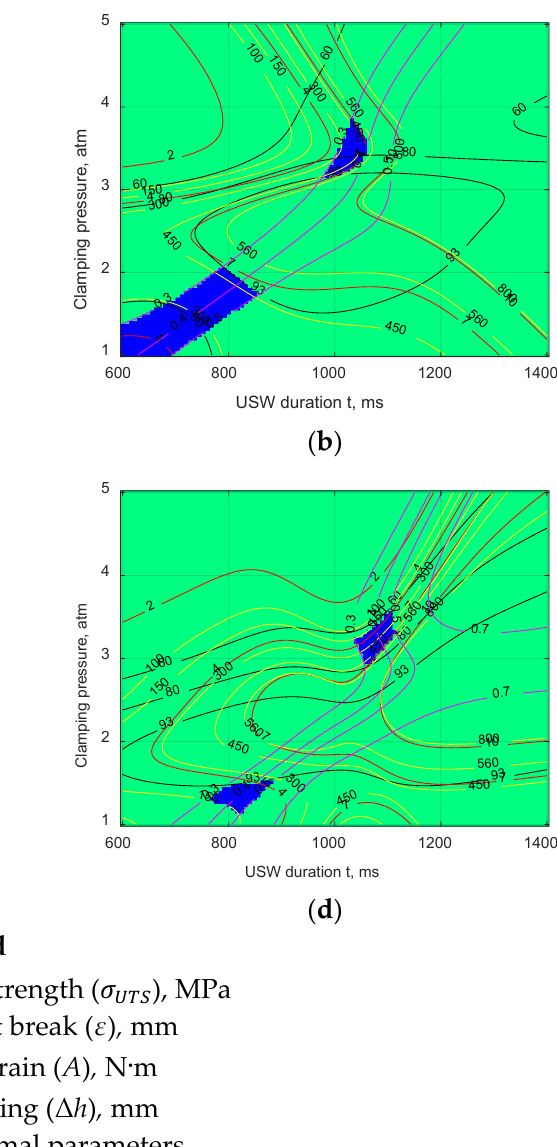
Legend ultimate tensile strength ( ), MPa elongation at break ( ε ) , mm 𝜎𝜎 𝑈𝑈𝑈𝑈𝑈𝑈 work of strain ( A ) , N·m joint thinning ( Δ h ) , mm areas of the optimal parameters Figure 7. The graphs in the isolines for the sections of the space of ANN parameters; the clamping Figure 7. The graphs in the isolines for the sections of the space of ANN parameters; the clamping duration after US vibrations of 1500 ms: ( a ) model 2; ( b ) model 3; ( c ) model 4; ( d ) model 5. duration after US vibrations of 1500 ms: ( a ) model 2; ( b ) model 3; ( c ) model 4; ( d ) model 5. Model 2. The extended optimality region was oriented horizontally at P = 3.0